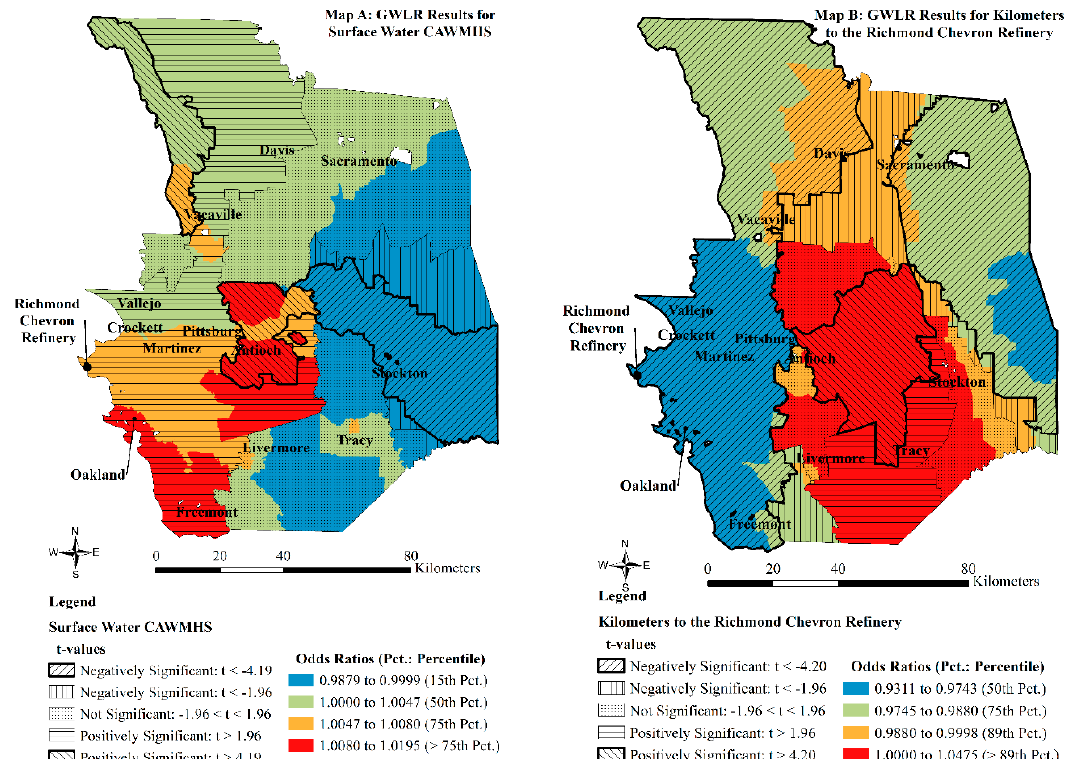
Figure 11. GWLR t -values and odds ratios for Map ( A ) Black disadvantage and Map ( B ) isolated Latinx disadvantage.